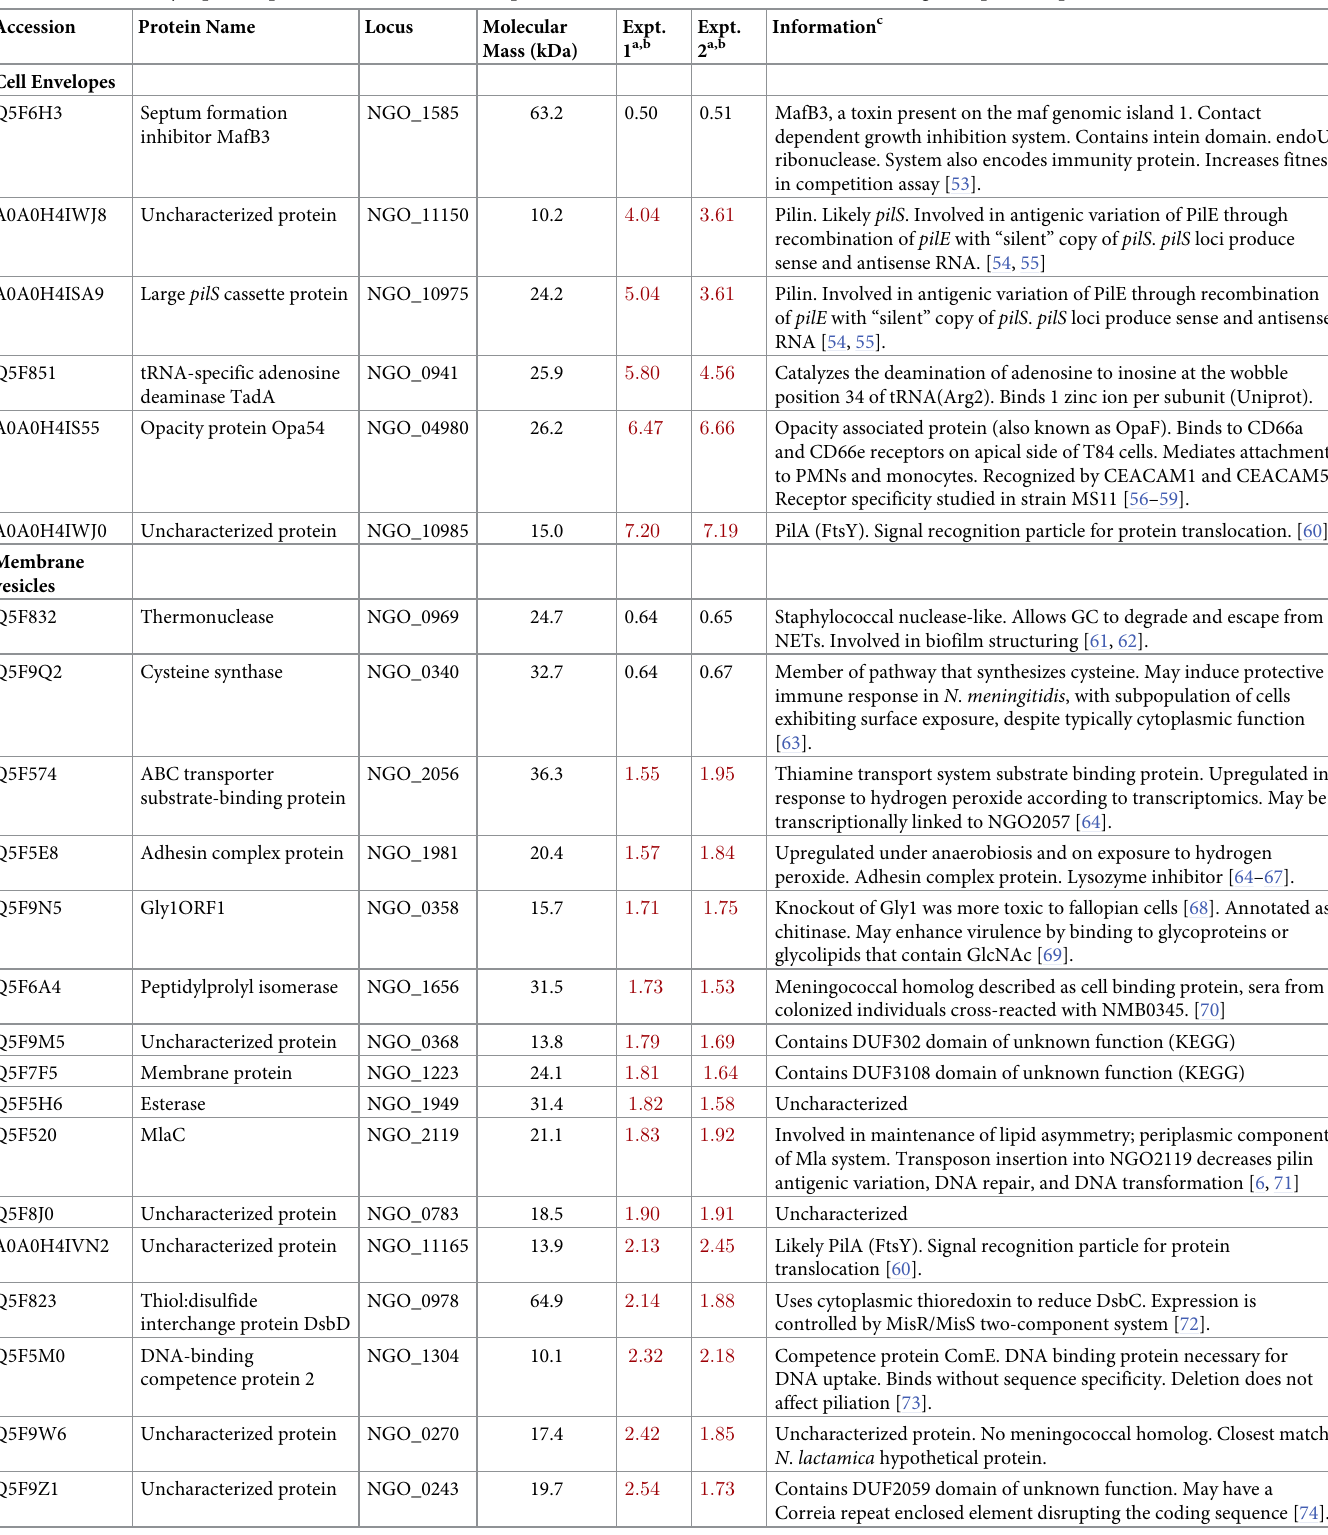
Table 3. Differentially expressed proteins in Δ mlaA cell envelopes and membrane vesicles identified in two biological replicate experiments.